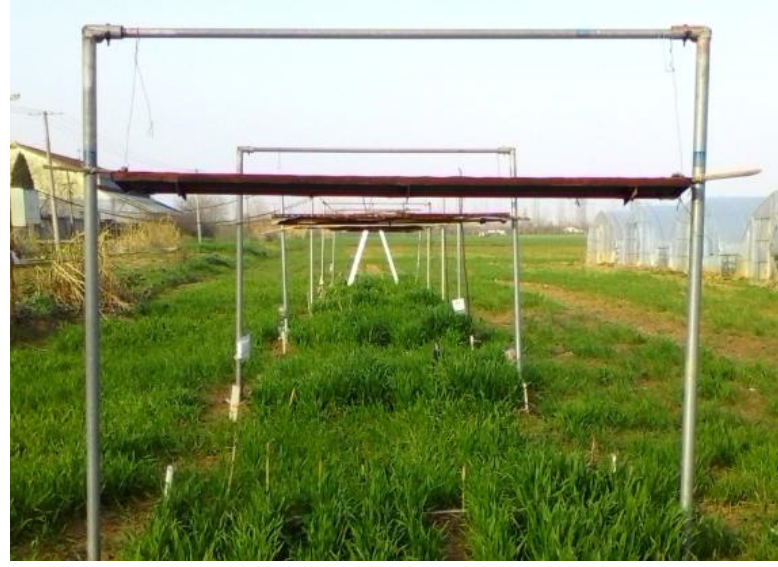
Figure 1. System structure of Free Air Temperature Increased (FATI) in winter wheat field.